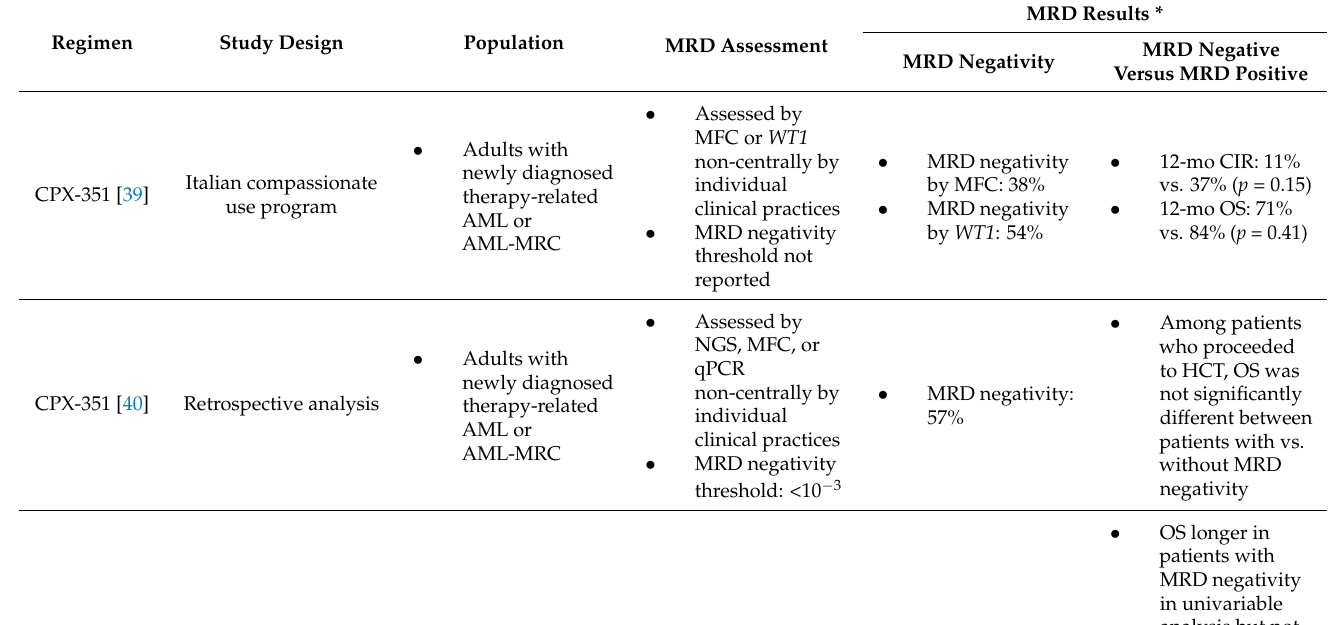
Table 3. Studies including MRD assessments in high-risk